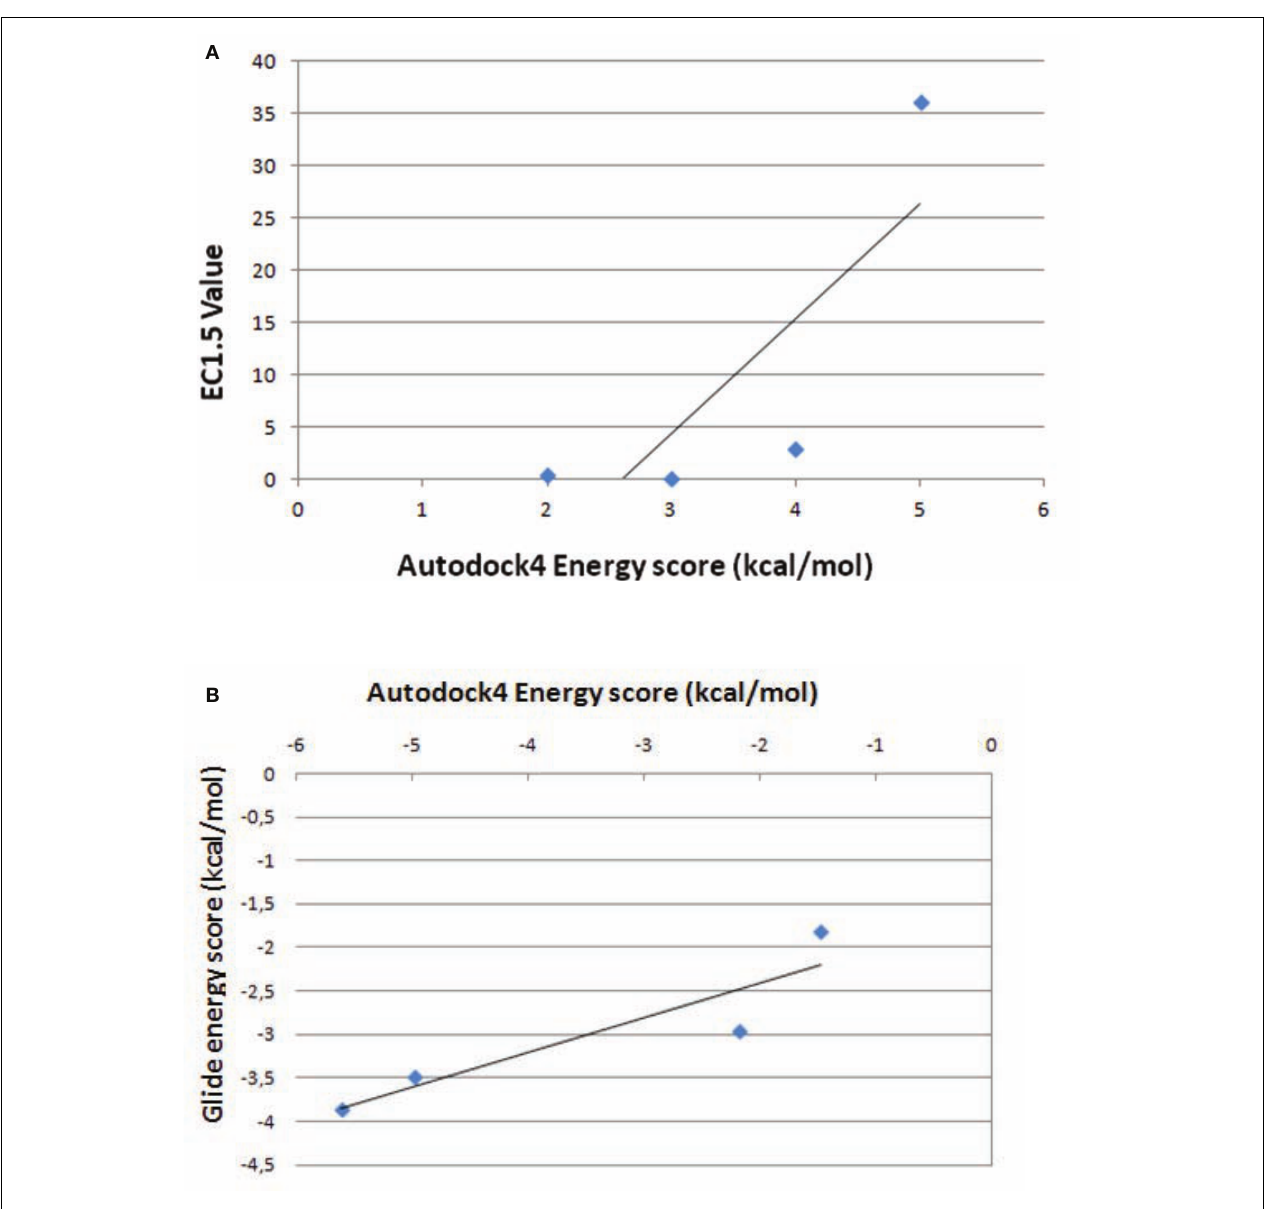
FIGUREA9 | Correlation between energy scores byAutoDock4 and the values of EC 1.5 , experimentally determined (A) between energy scores by AutoDock4 and Glide programs (B).